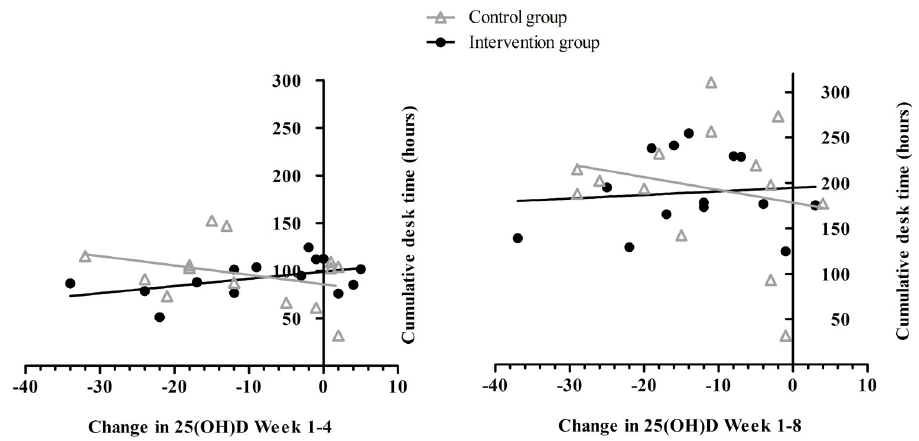
Fig 4. Correlations between cumulative desk time and change in 25(OH)D from baseline to Week 4 and baseline to Week 8 for both groups.